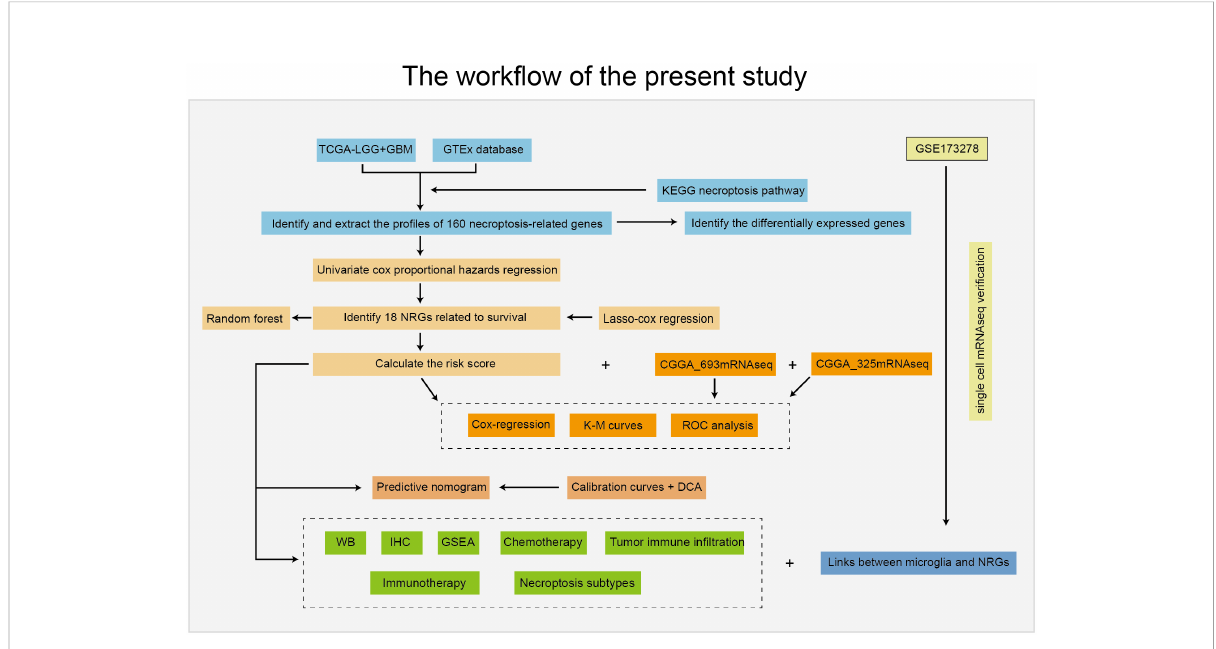
FIGURE 1 Work fl ow used in this